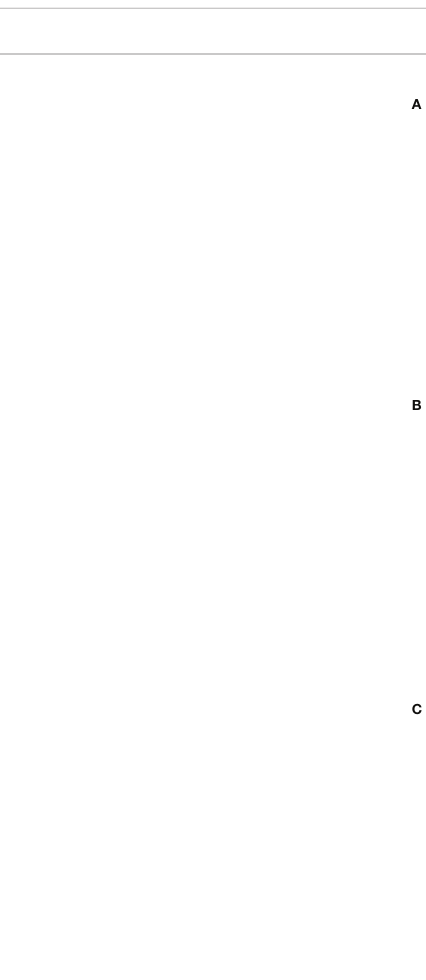
FIGURE 6 | External validation correction in 3-year (A) and 5-year (B) for a nomogram of the overall survival in node-negative triple-negative breast cancer patients with tumor size less than 1 cm.